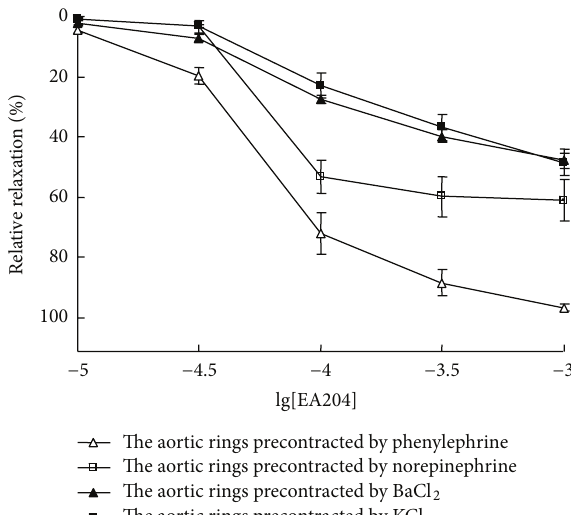
The aortic rings precontracted by phenylephrine The aortic rings precontracted by norepinephrine The aortic rings precontracted by BaCl 2 The aortic rings precontracted by KCl Figure 3: Endothelium-independent vasorelaxant effects of EA204 on denuded aortic rings of rabbits precontracted by phenylephrine (1 𝜇 M), norepinephrine (3 𝜇 M), high-K + solution (60 mM), and BaCl 2 (2mg/mL), respectively. Endothelium was removed mechan- ically by rubbing with a steel wire. Responses are expressed as a percentage of the maximum possible relaxation, that is, relaxation back to the baseline tension. Values indicated the means ± SEM ( 𝑛 = 8 ).